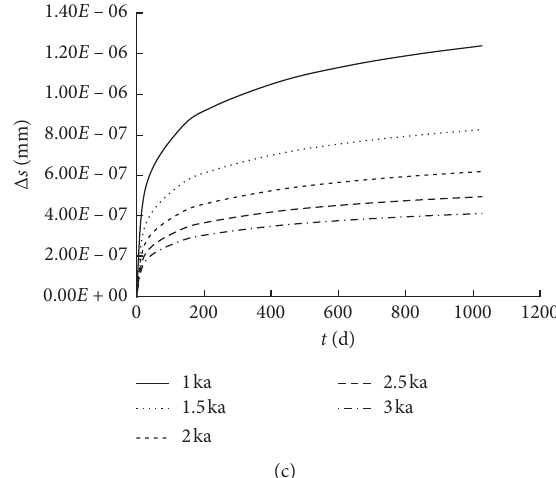
Figure 11: The effect of adhesive stiffness under creep on the interface slip. (a) Uniform load. (b) Symmetrical concentrated load. (c) Midspan concentrated